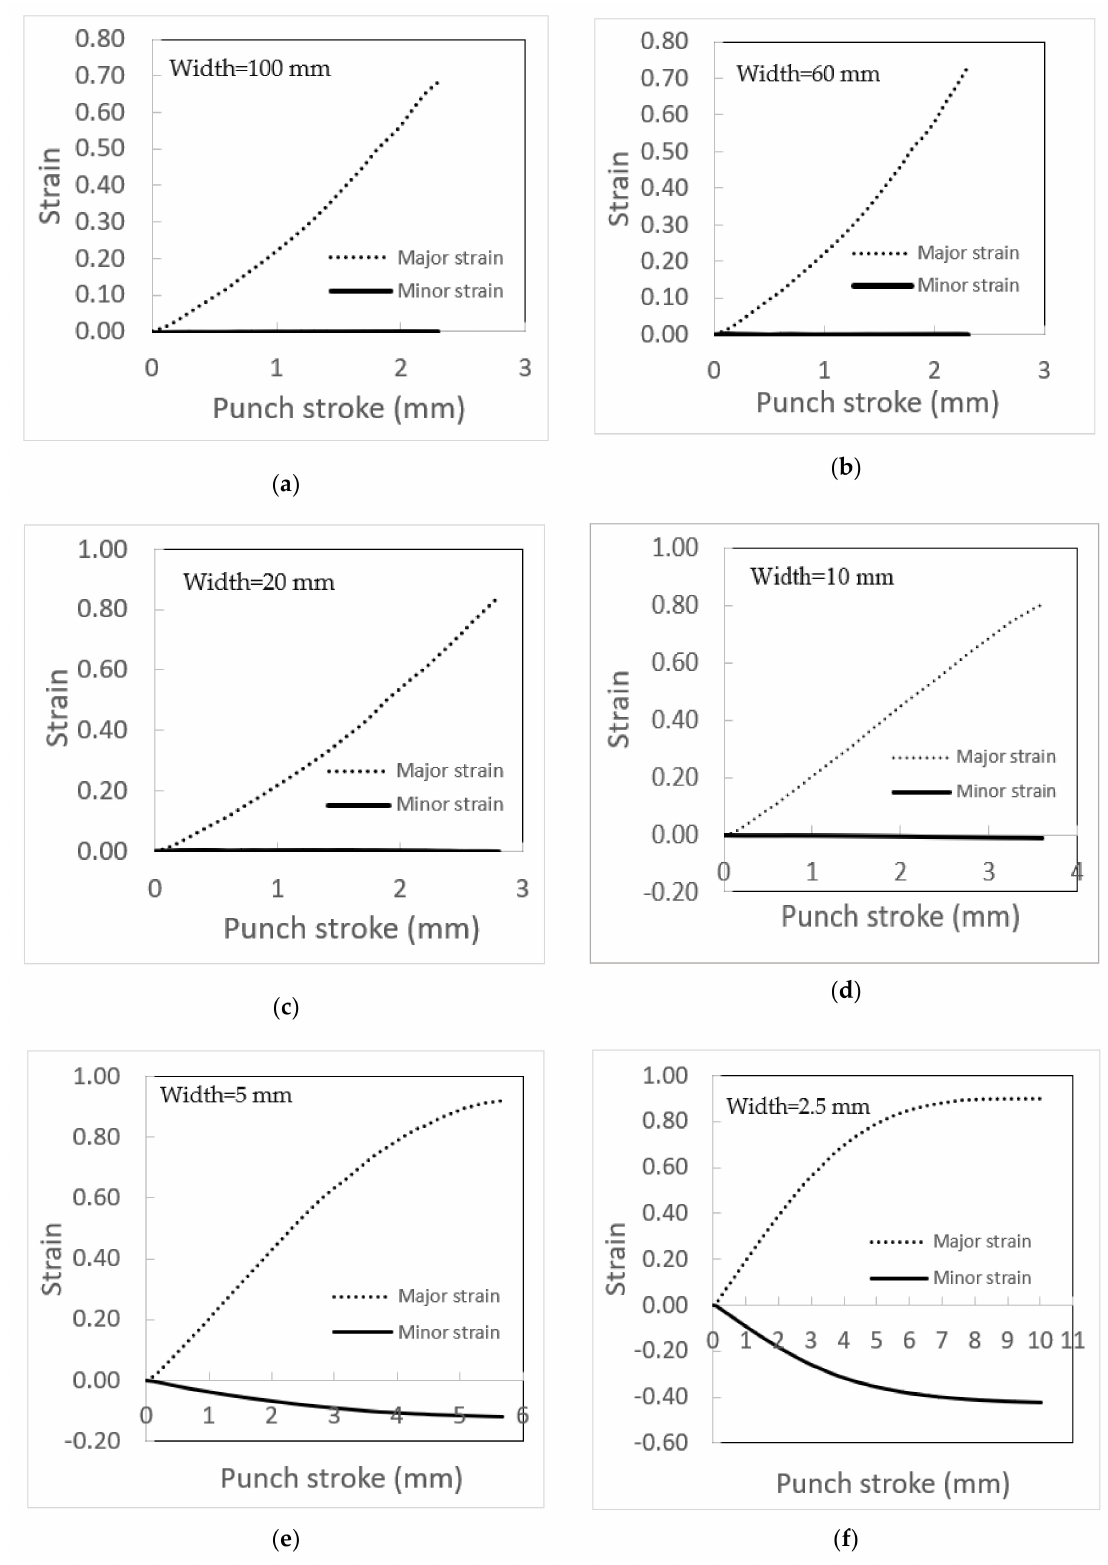
Figure 7. Major and minor strain in metal sheets with various width/thickness ratios; ( a ) width = 100 mm, ( b ) width = 60 mm, ( c ) width = 20 mm, ( d ) width = 10 mm, ( e ) width = 5 mm, and ( f ) width = 2.5